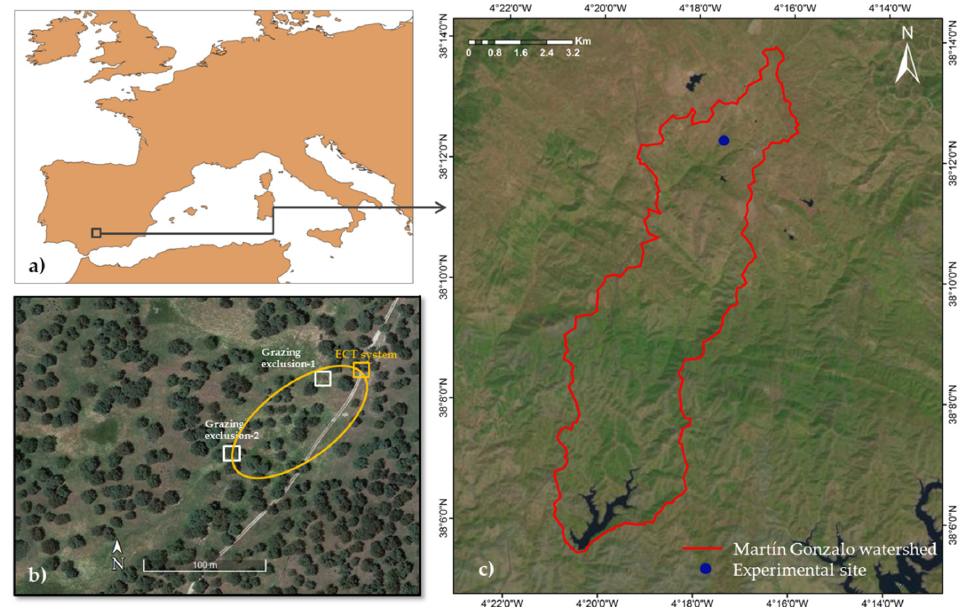
Figure 1. ( a , c ) Location of the study area and experimental site; ( b ) Aerial photograph of validation site showing the distribution of the three fields discussed in the text. ECT: eddy covariance tower. The orange ellipse represents the predominant fetch of the ECT.